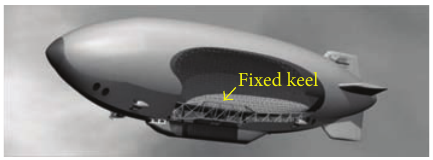
Figure 10: Semirigid airship.